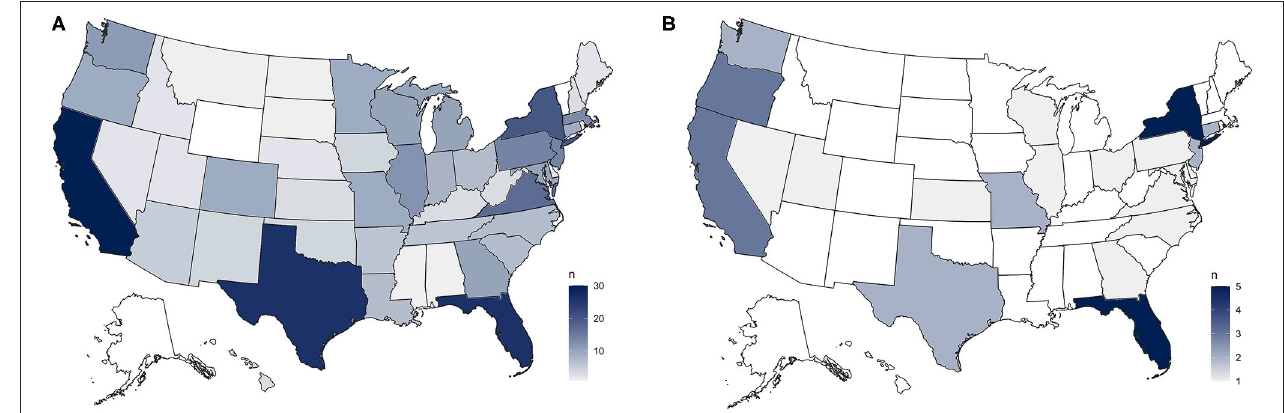
FIGURE 3 | (A) In asking organizations how they decided where to trap cats for sterilization, our most common answer was via requests from colony caretakers, which followed a distribution similar to our overall sample. (B) Our least common trapping motivation, areas where cats were suspected to pose a risk to birds, was selected the most by organizations from New York and